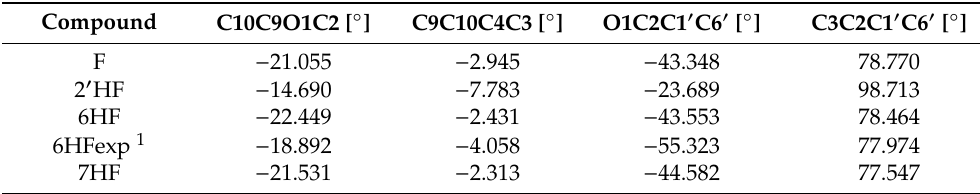
Figure 4. The DFT(B3LYP)/6-31G(d,p)/PCM optimized geometries of the 2S-flavanones: F, 2’HF, 6HF and 7HF. The atom numbering is presented for F; the same is for 2’HF, 6HF and 7HF. (Gaussian 09 and GaussView 5.0.8 [67,68]; Paint/Windows 10; Microsoft Office PowerPoint 2007 software). Table 1. The selected geometrical parameters of the DFT(B3LYP)/6-31G(d,p)/PCM optimized structures. The atom numbering is the same as for F in Figure 4.